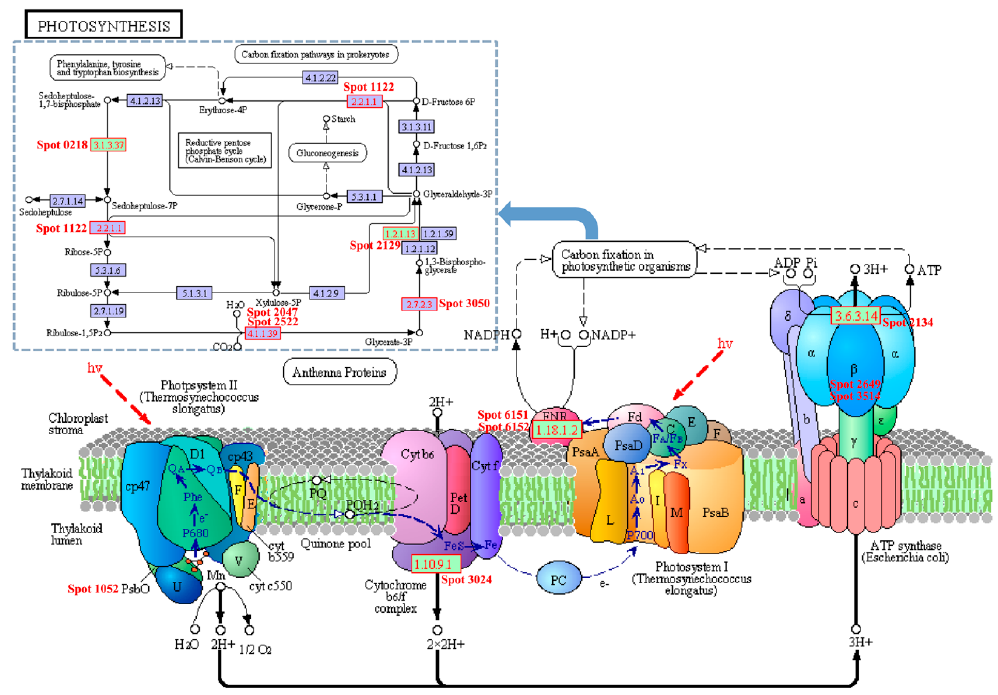
Figure 6. Identified proteins involved in photosynthesis in G. biloba . The blue dashed outline on the wireframe indicates the proteins that are involved in carbon fixation in photosynthetic organisms.